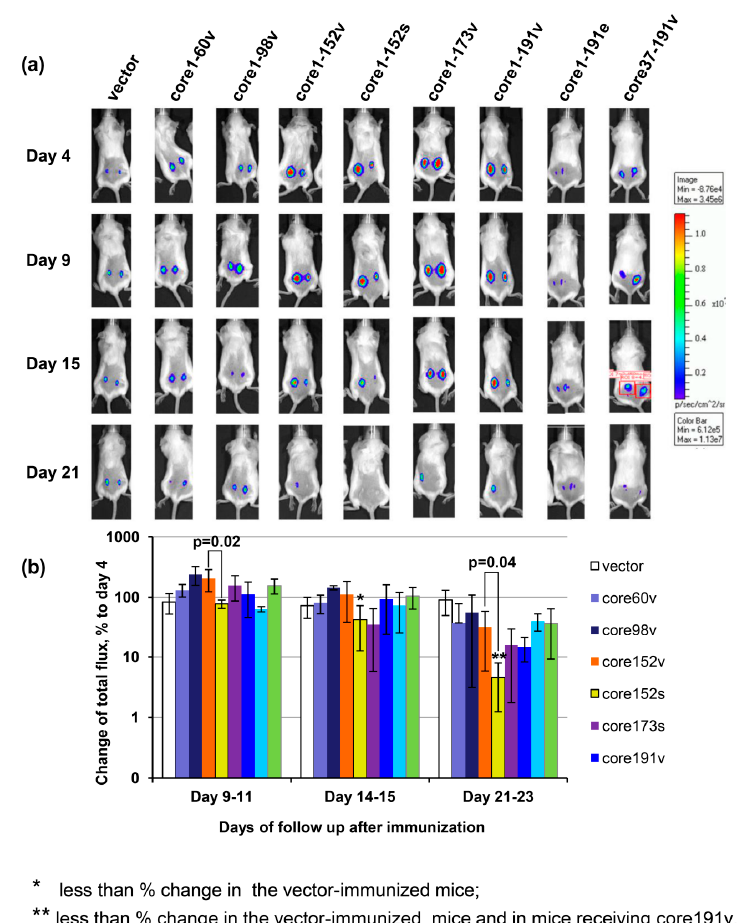
Figure 7. The effector potential of anti-core immune response in BALB/c mice visualized as the capacity to reduce bioluminescent signal emitted from the areas of co-delivery of HCV core variant and luciferase reporter encoding DNA. Composite image of representative mice receiving injections of plasmid encoding one of the HCV core gene variants mixed with plasmid encoding firefly luciferase (Luc; pVaxluc), showing bioluminescence from the injection areas to the left and to the right of the back, on days 4, 9, 15, and 21 post immunization. ( a ); Average luminescence from all injection sites in a group normalized to the level reached in this group by day 4 post immunization, in % ± SD ( b ); Correlations of IFN- γ and dual IFN- γ /Il-2 response to HCV core aa 1–56 with the loss of luminescence (Spearman rank test; p < 0.05) ( C ). Mice were immunized by intradermal injection of plasmids carrying viral (HCV 1b